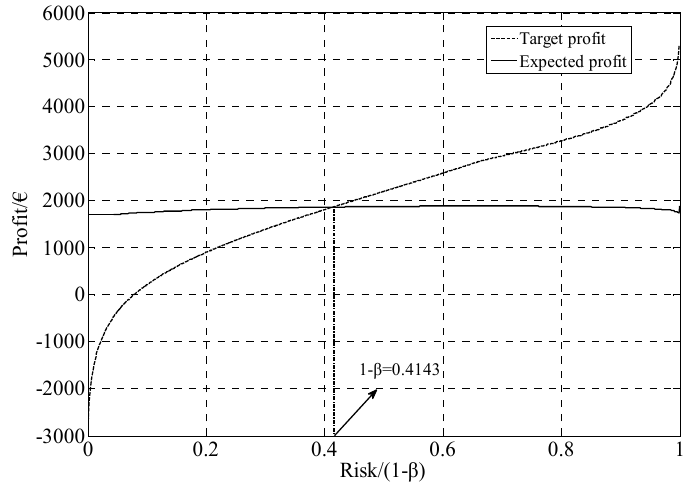
Figure 10. Change trend of target profit and expected profit versus risk under the ECPS.